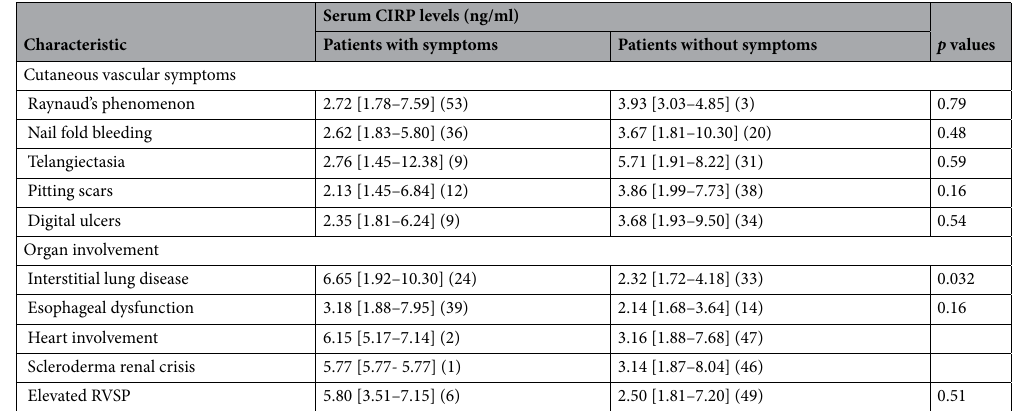
Table 1. Association of serum CIRP levels with clinical features in SSc patients. Clinical manifestations are defined as follows: pitting scars, pinhole-sized digital hyperkeratosis; digital ulcers, a loss of epithelialization; intestinal lung disease, the presence of ground-glass opacity and/or reticular pattern on computed tomography analysis; esophageal dysfunction, abnormal reflux of gastric contents or symptoms associated with gastroesophageal reflux disease; heart involvement, symptomatic pericarditis, clinical evidence of left ventricular congestive heart failure, and/or arrhythmias requiring treatment; elevated right ventricular systolic pressure (RVSP), ≥ 35 mmHg on echocardiogram; scleroderma renal crisis, malignant hypertension and/ or rapidly progressive renal failure, malignant hypertension and/or rapidly progressive renal failure. Values represent the median with 25–75 percentiles in square brackets and patient numbers in parentheses.